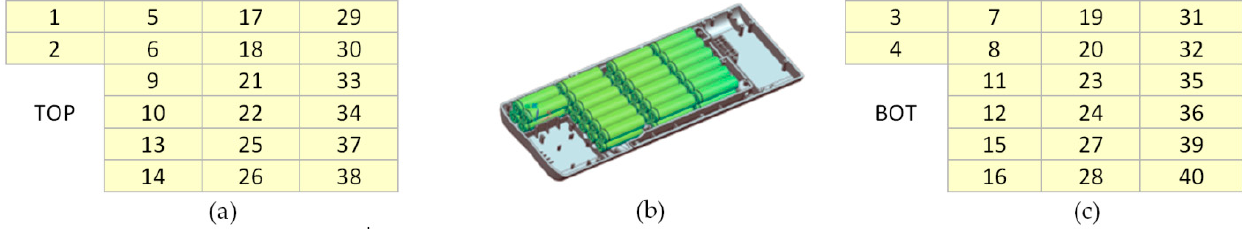
Figure 13. Labels of individual cells in the pack arrangement, an assembly ( b ); a top cell layer TOP ( a ); a bottom cell layer BOT ( c ).